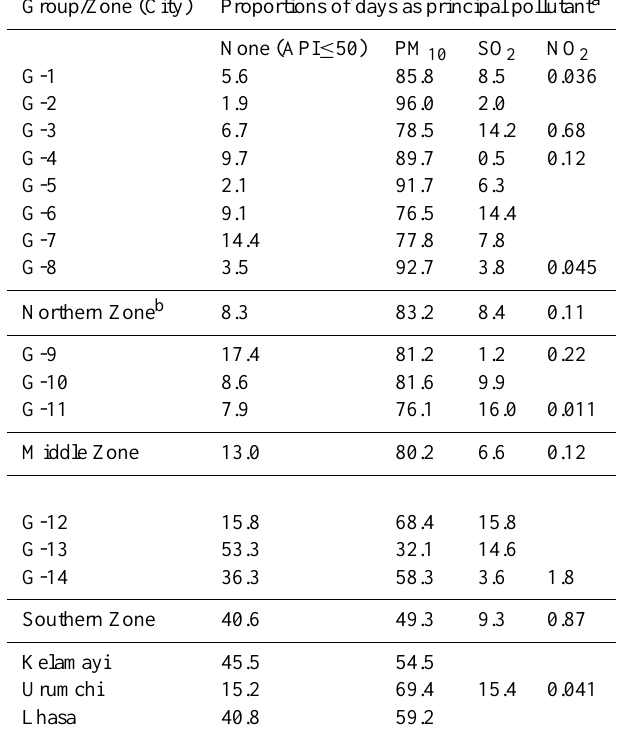
Table 3. Proportions of days with PM 10 , SO 2 and NO 2 as the prin- cipal pollutant in the full set of air pollution index (API) records for the fourteen groups and three latitudinal